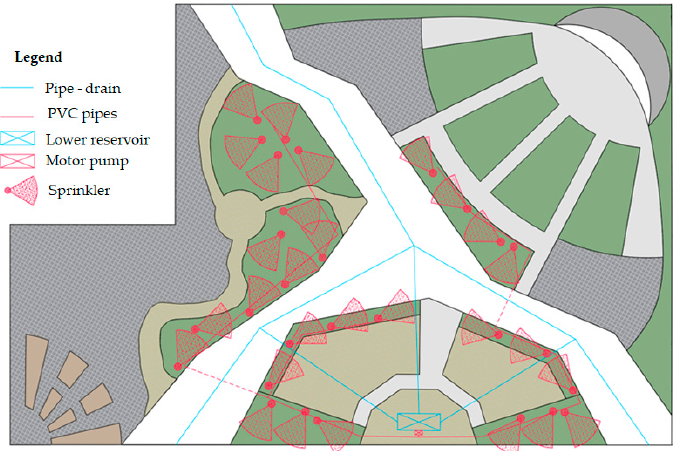
Figure 8. Irrigation system.